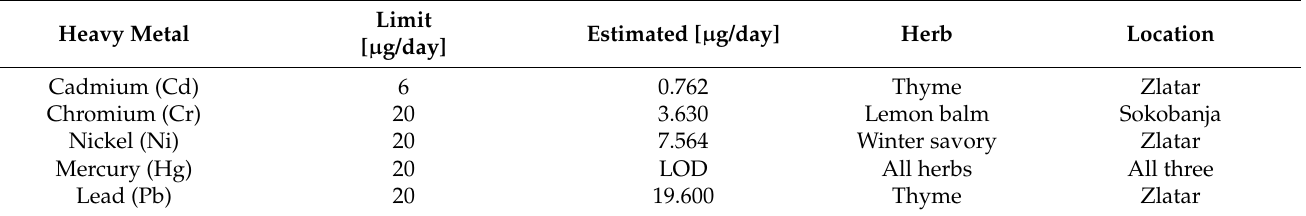
Table 5. Limits for toxic metals intake according to National Sanitation Foundation draft proposal (Finished Dietary Supplement), WHO, 2007 [38], and the values obtained from this